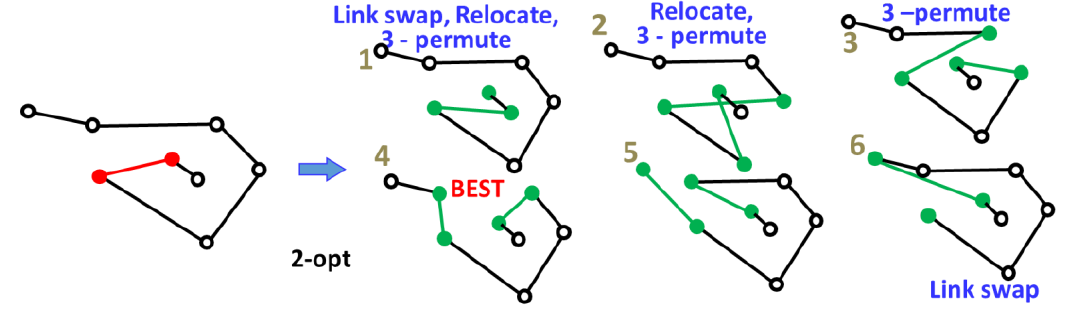
Figure 9. Six neighboring solutions created by 2-opt, of which two are unique.